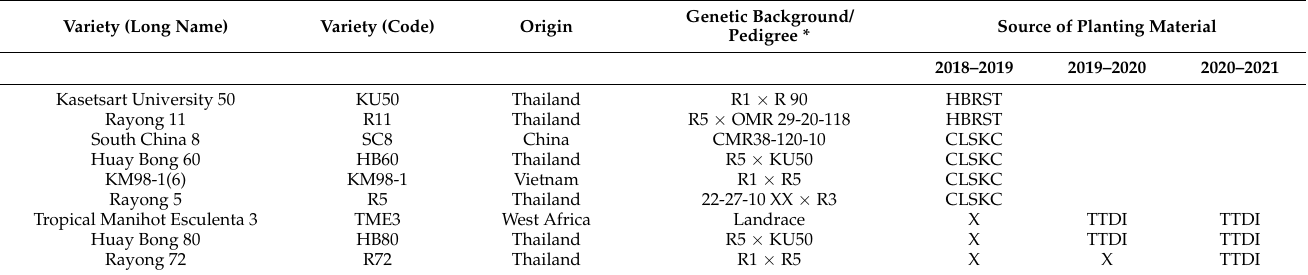
Table 1. Name, country of origin, genetic background/pedigree, and source of clean/disease free planting stakes of cassava varieties used in experiments during three